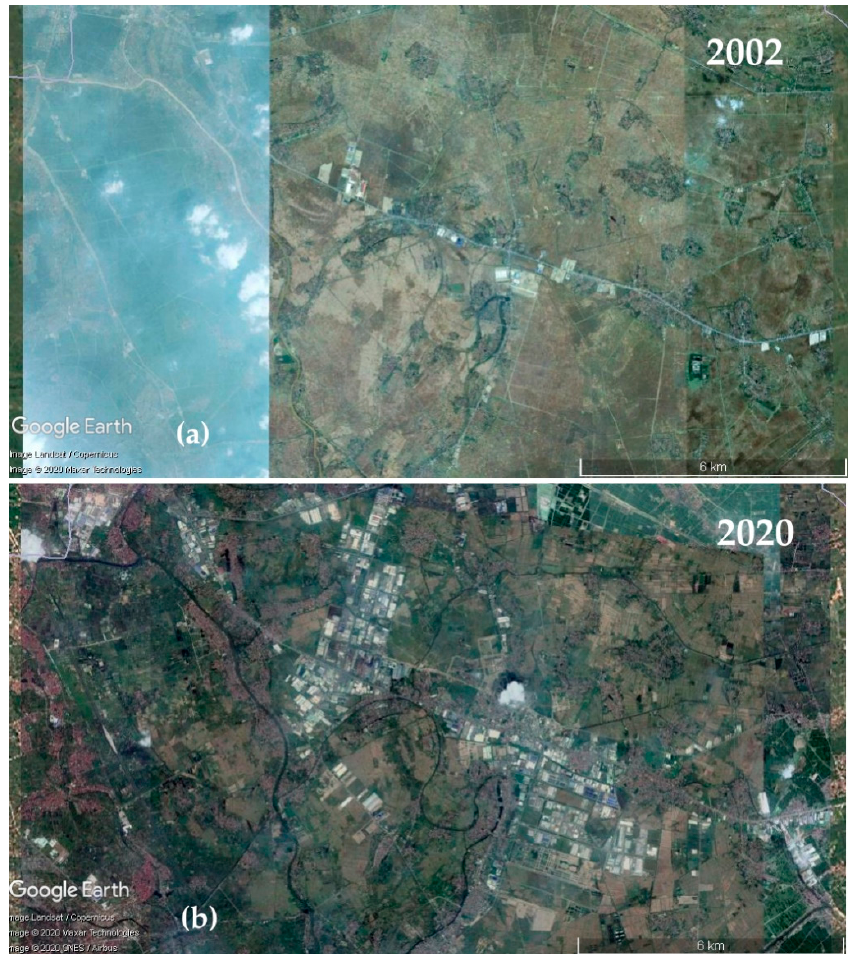
Figure 10. The Pho Noi area: ( a ) the rural region in 2012; ( b ) the industrial park in 2019 (source: Google Earth).